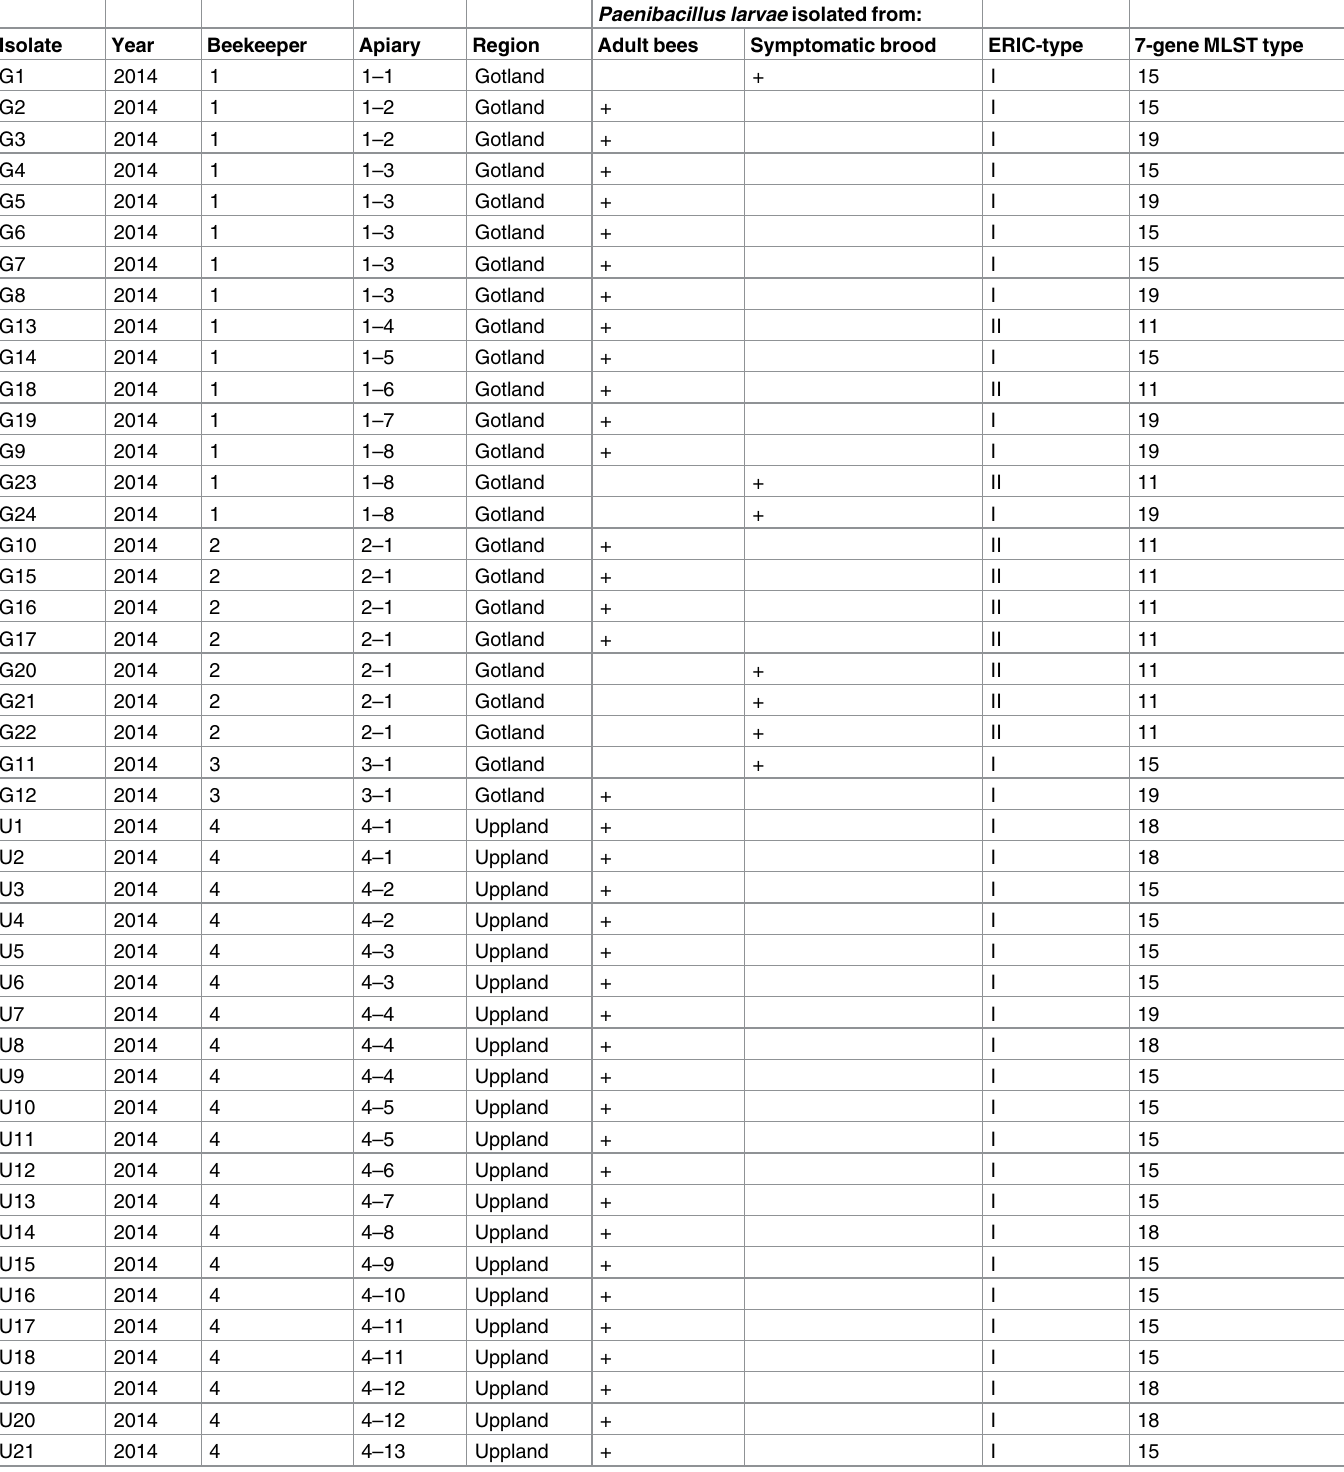
Table 1. Isolates included in the study, year of sampling, beekeeper,geographic and biological origin, ERIC-typing and 7-gene MSLT results. Iso- lates from Gotland are marked with the prefix “G” and isolates from Upplandwith the prefix “U”.